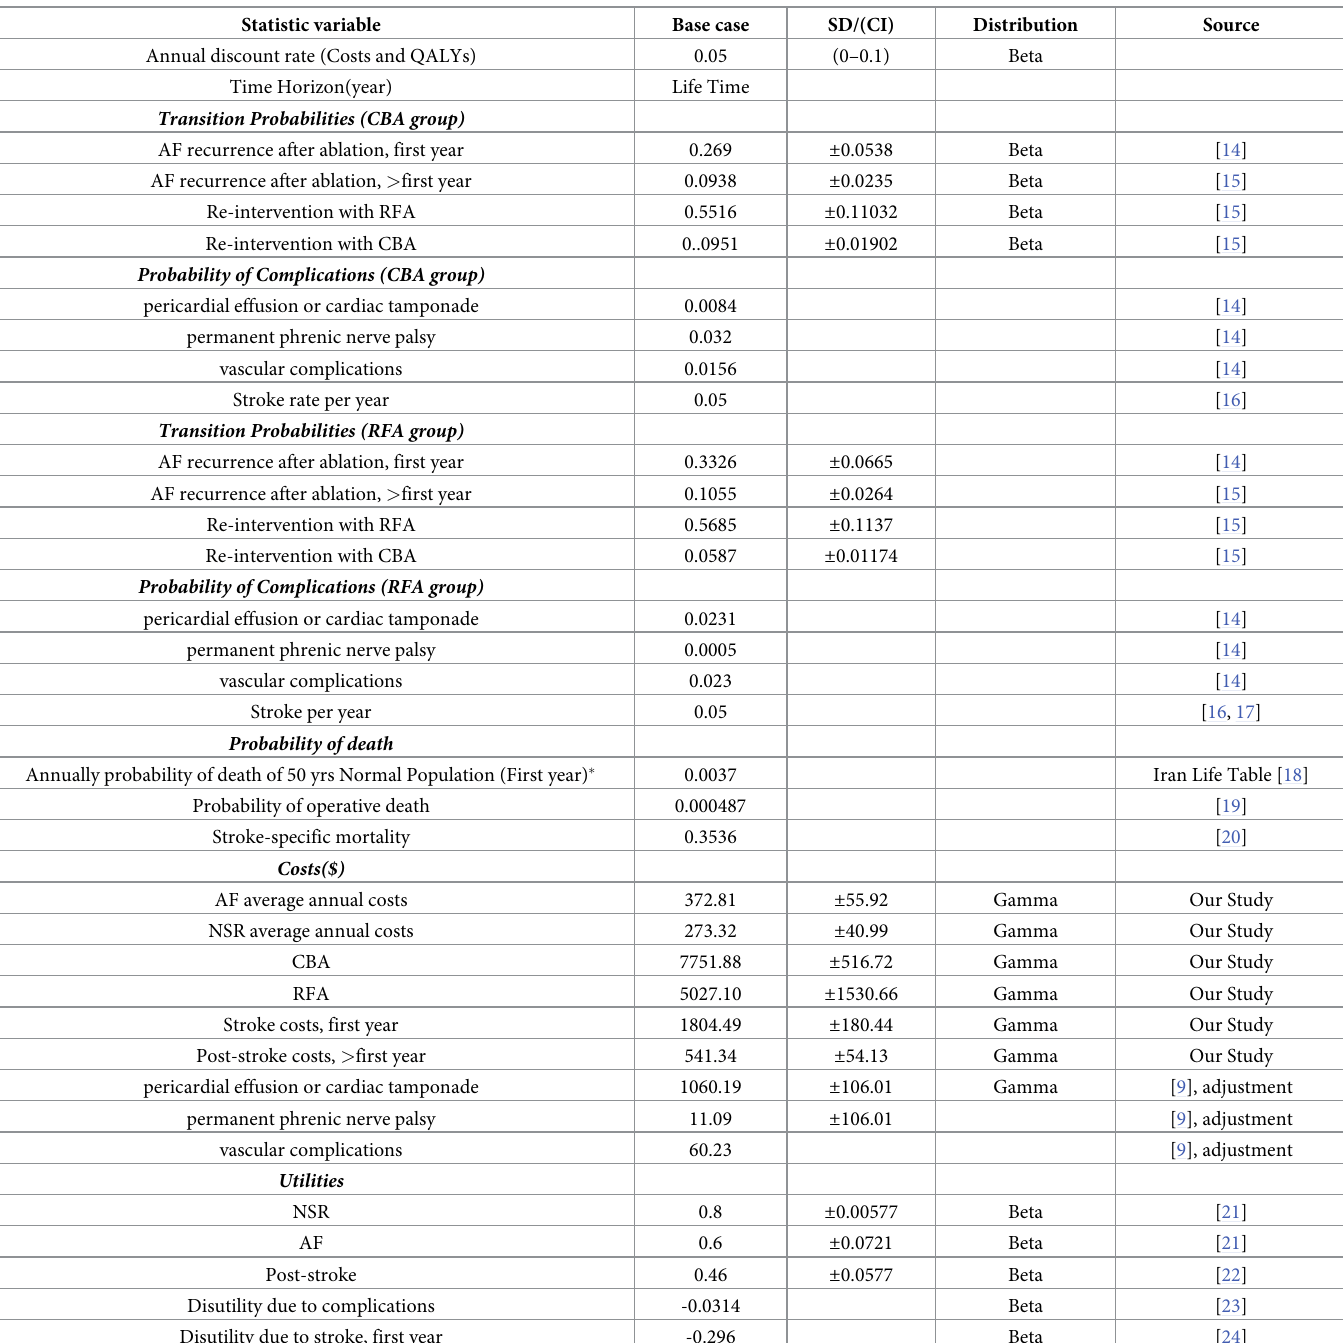
Table 1. Model inputs and parameters.